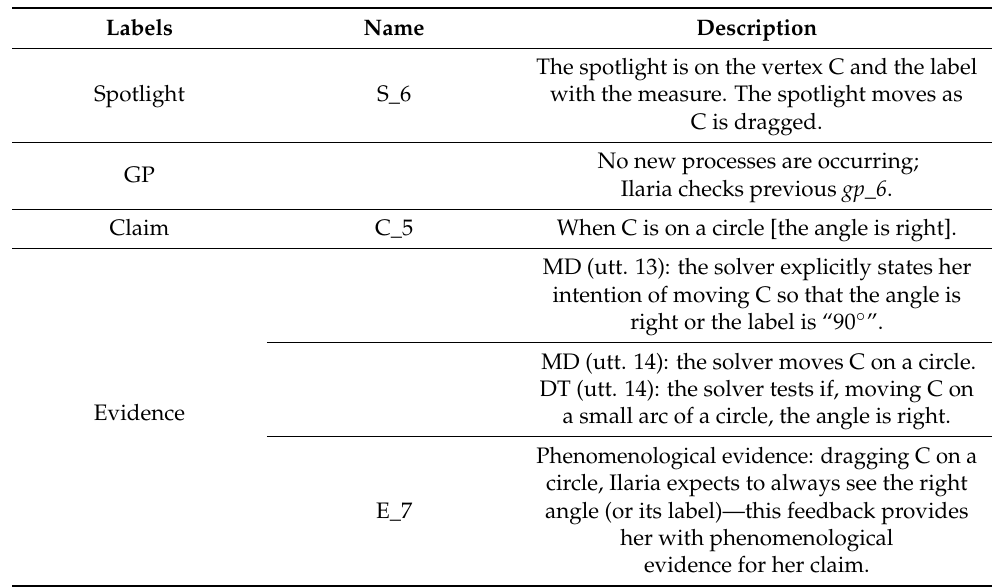
Table 10. Main elements from the analysis of Excerpt 5.